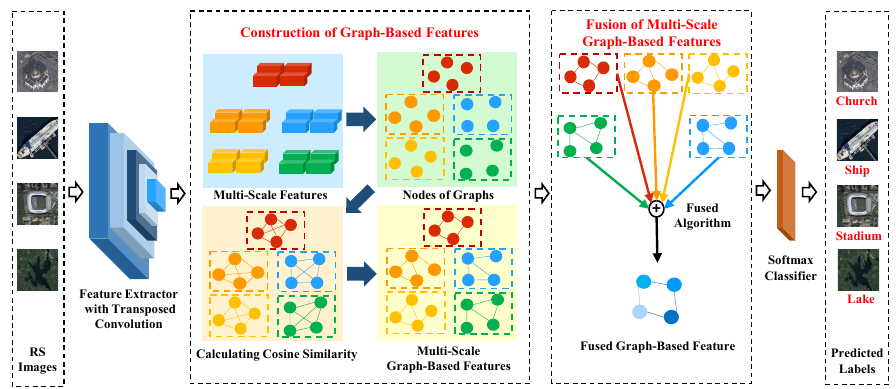
Figure 1. The framework of proposed multi-scale graph-based feature fusion